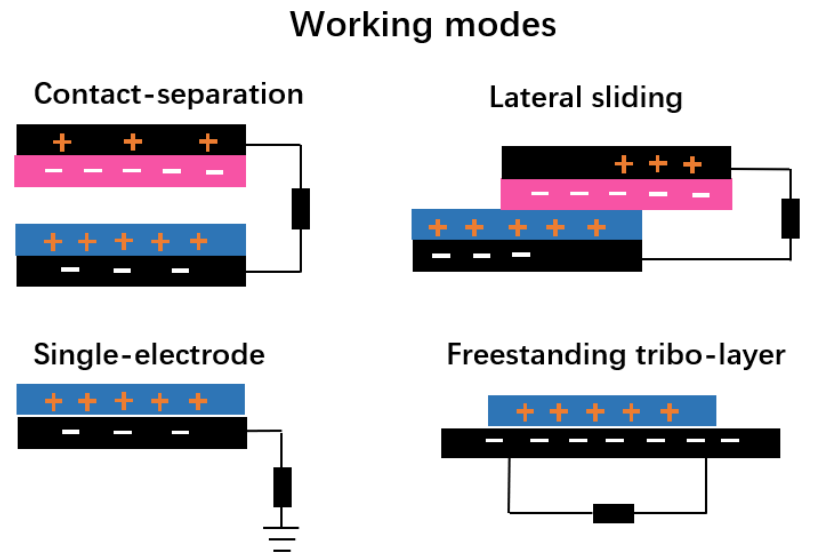
Figure 3. Working modes of TENGs.